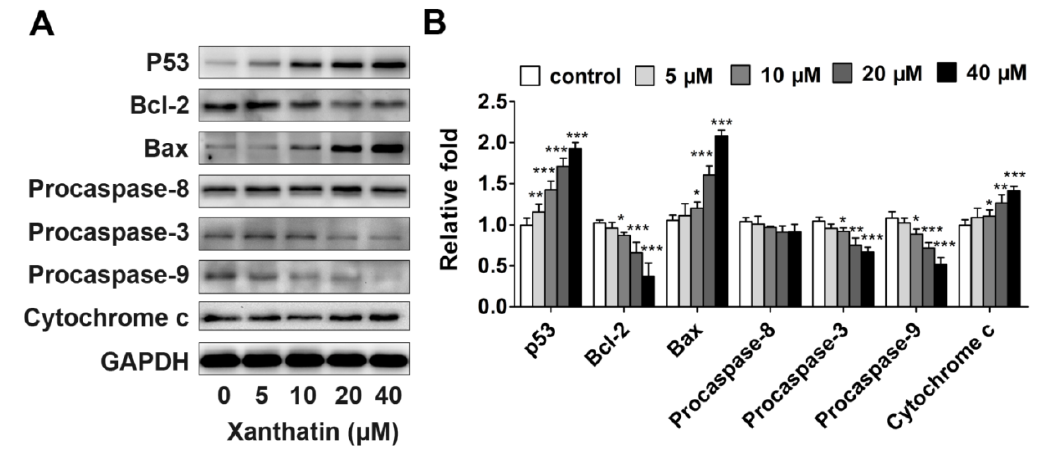
Figure 5. Western blot analysis of apoptosis-related proteins in A549 cells treated with xanthatin. ( A ) Protein expression of p53, Bax, Bcl-2, procaspase-8, procaspase-3 and procaspase-9 in A549 cells treated with xanthatin at indicated concentrations for 24 h. GAPDH was used as the control; ( B ) Densitometry analysis of the protein levels of apoptosis-related proteins in A549 cells treated with xanthatin. Data were presented as means ± SD by three independent experiments. Significance: * p < 0.05 versus the control; ** p < 0.01 versus the control, *** p < 0.001 versus the